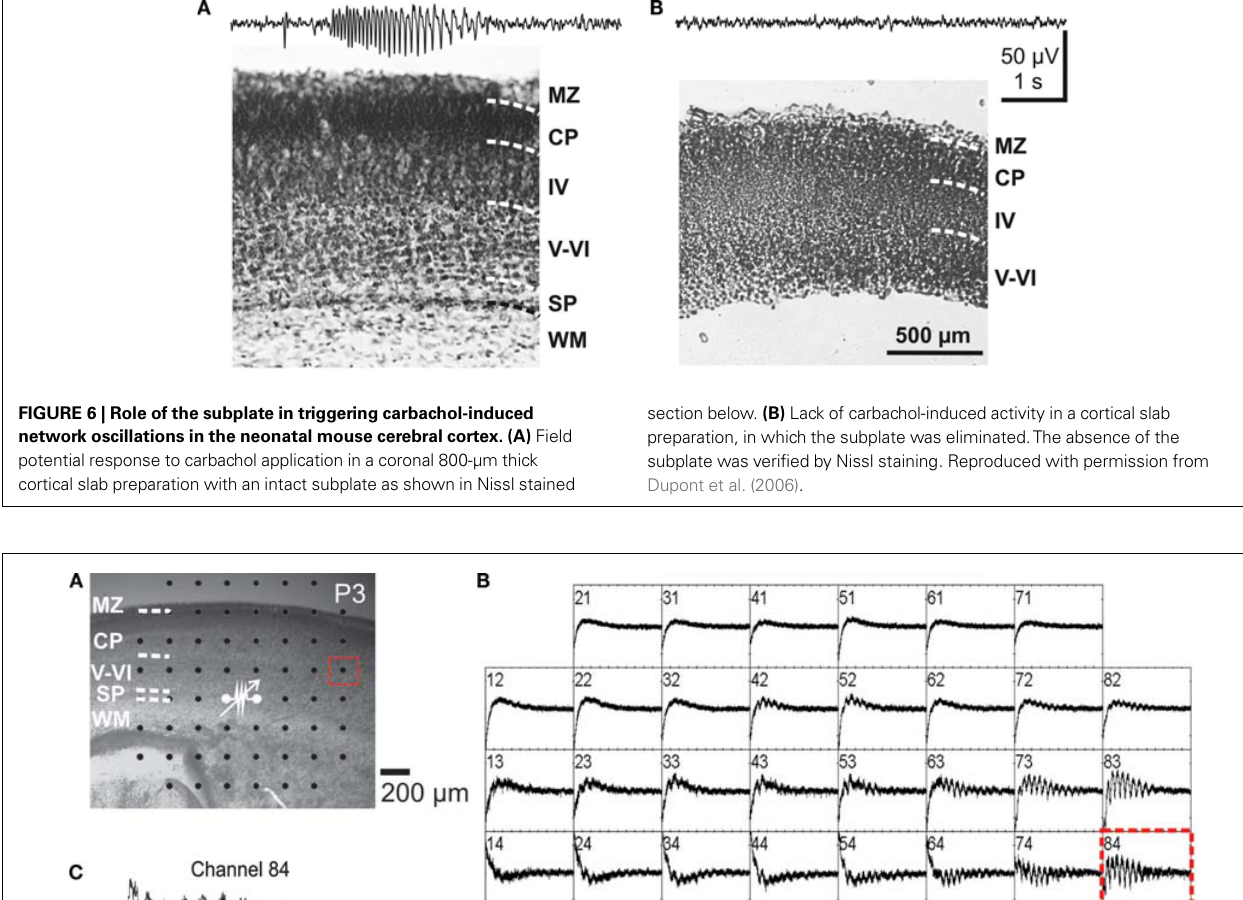
FIGURE 7 | Local electrical stimulation of the subplate elicits propagating network oscillations in the developing cerebral cortical network of the newborn mouse. (A) Photograph of P3 mouse Nissl-stained coronal slice with cortical layers and position of 60-channel multi-electrode array (MEA). (B) MEA recordings from the neocortical slice shown in (A) with site of bipolar stimulation